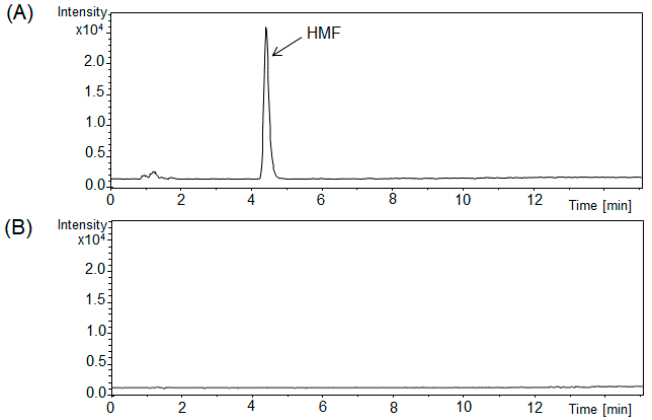
Figure 1. Liquid chromatography/mass spectrometry (LC/MS) chromatograms ( m / z 433 [M + H] + ) of brain tissues from mice treated orally with 3,5,6,7,8,3 ′ ,4 ′ -heptamethoxyflavone (HMF) ( A ) and vehicle-treated brains ( B ). The solid arrow is HMF.